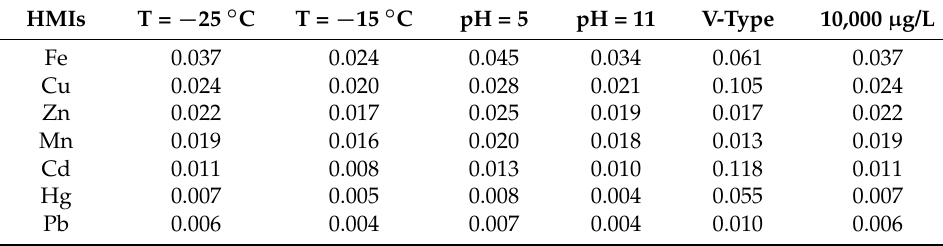
Figure 3. The heavy mental concentrations in ice under different conditions. Table 2. The distribution coefficients ( K ) of heavy metals under different conditions.